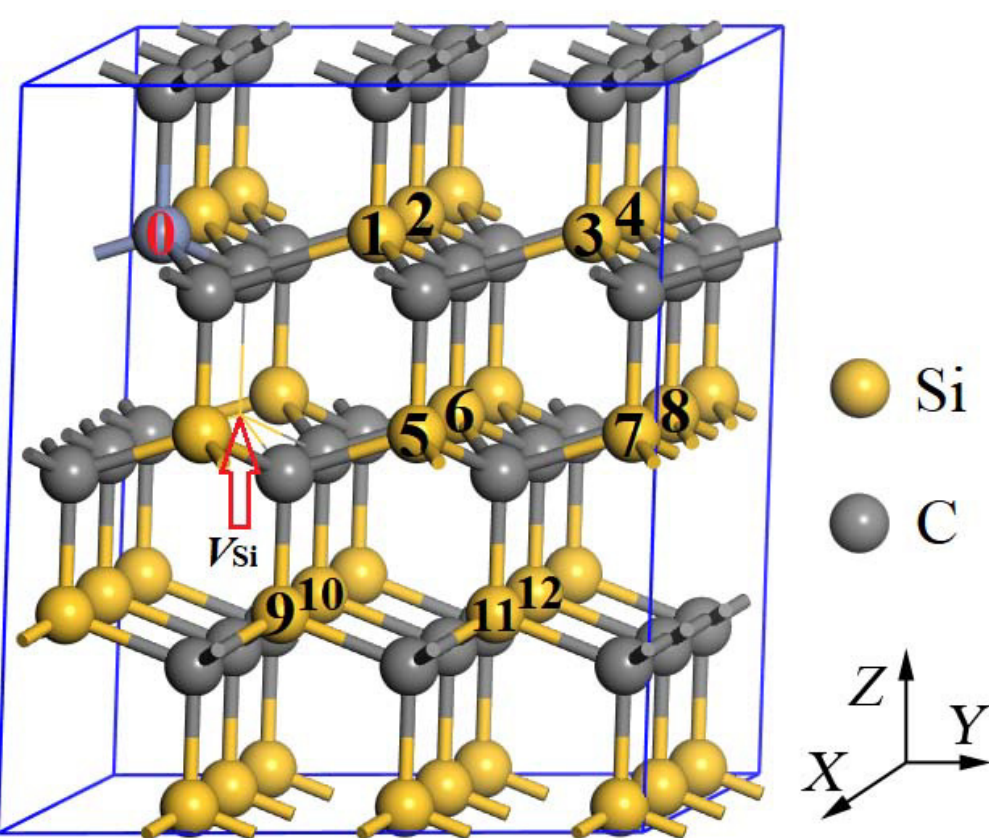
Figure 1. A 3 × 3 × 1 supercell model of 4H–SiC with 72 atoms. The Cr dopants is fixed at the position labeled 0, the Si atoms labeled by 1-12 are the sites to bereplaced by the doped Co atoms. The silicon vacancy is labeled V Si